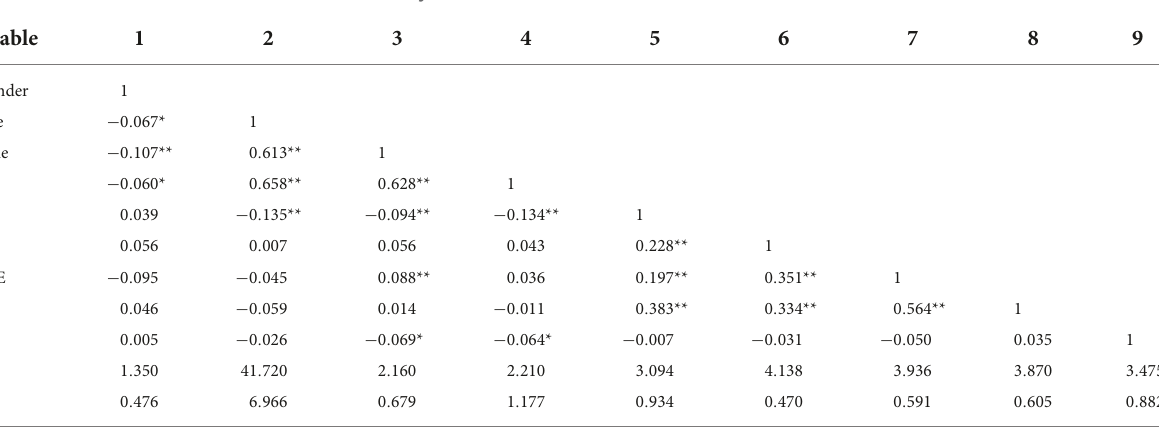
TABLE 3 Mean, standard deviation, and correlation analysis results of each